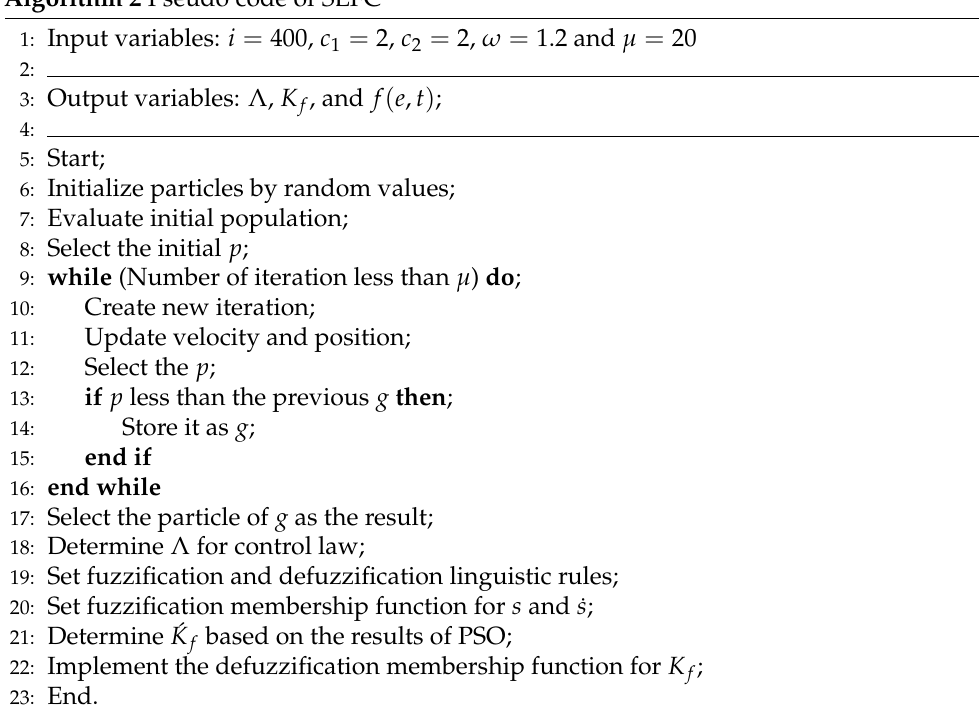
Algorithm 2 Pseudo code of